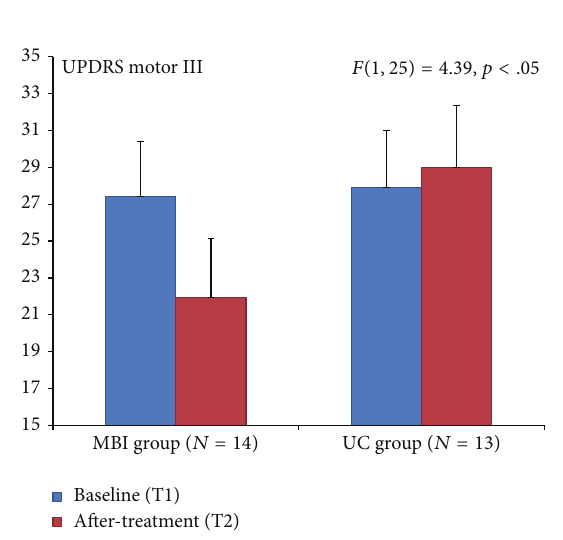
Figure 1: Unified Parkinson’s Disease Rating Scale (UPDRS) for motor change showed a significant effect for the MBI group.